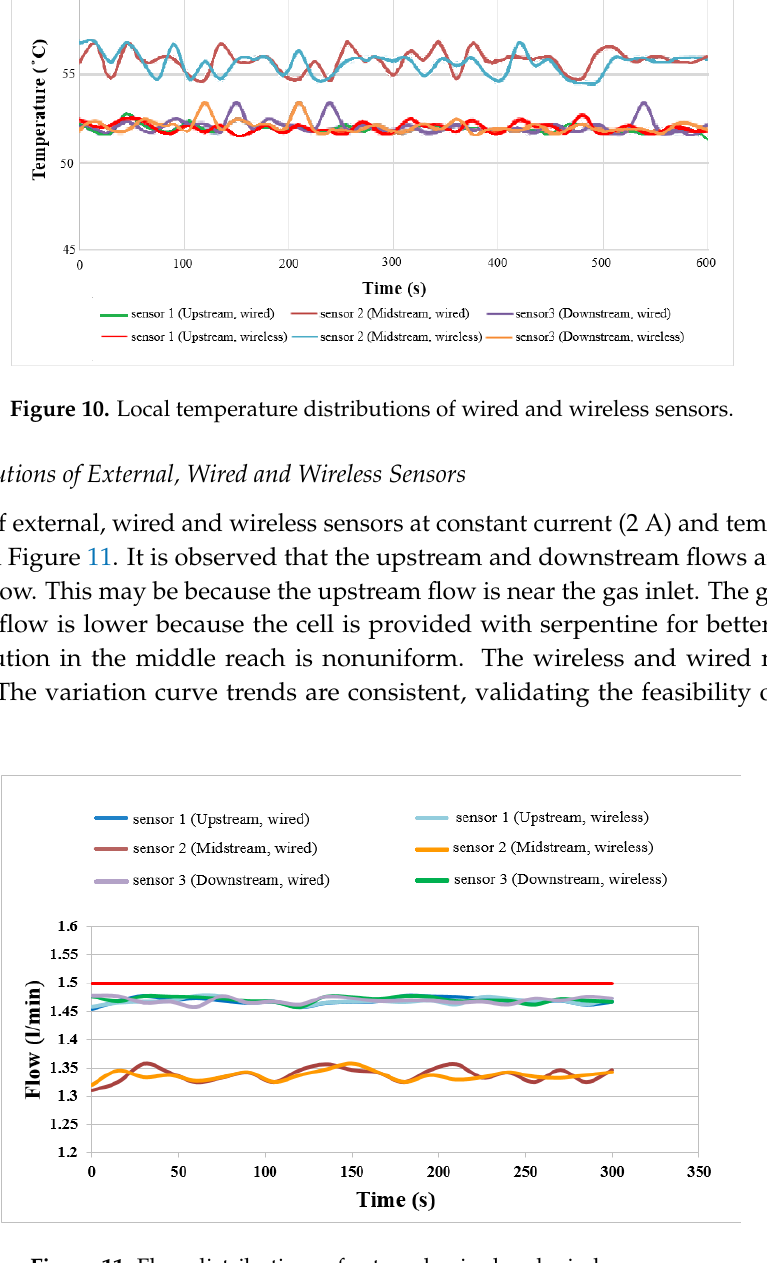
Figure 12. Local CO concentration distribution diagram of wired and wireless sensors.